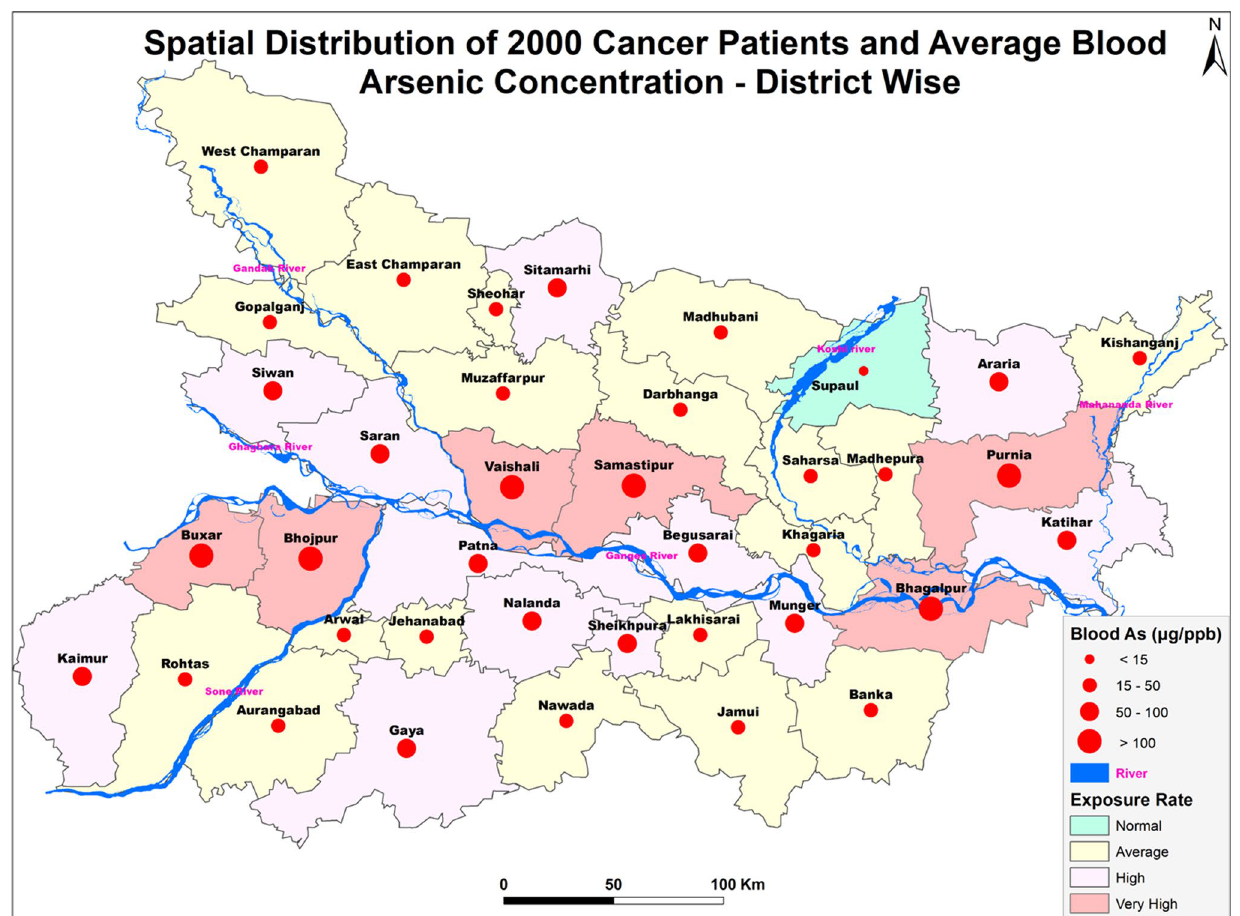
Figure 17. Geospatial Cancer distribution Map of 2000 Cancer patients with Average Blood Arsenic concentration—district wise [Base map extracted from OpenStreetMap—(http://downl oad.geofa brik.de/asia/ india .html) using